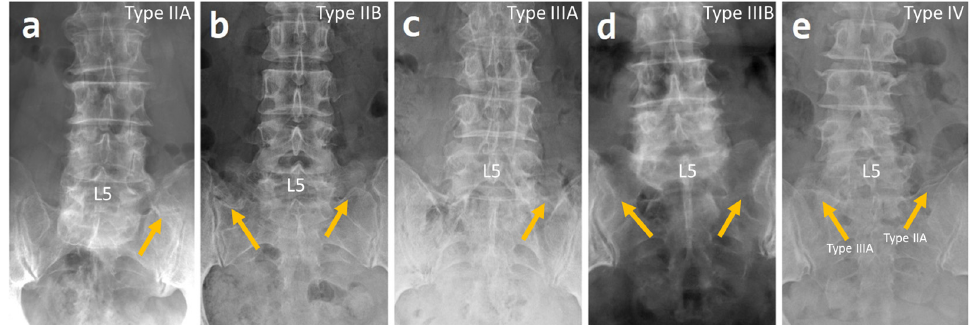
Figure 1. Castellvi classification of LSTV at L4-5 level. ( a ) Type IIA — Unilateral pseudoarthrosis of the transverse process. ( b ) Type IIB — Bilateral pseudoarthrosis. ( c ) Type IIIA — Unilateral complete fusion of the transverse process. ( d ) Type IIIB — Bilateral complete fusion. ( e ) Type IV: Type IIA on one side and Type IIIA on the other side. Type 1 was considered as a variation of normal. Arrows point to the anomalous